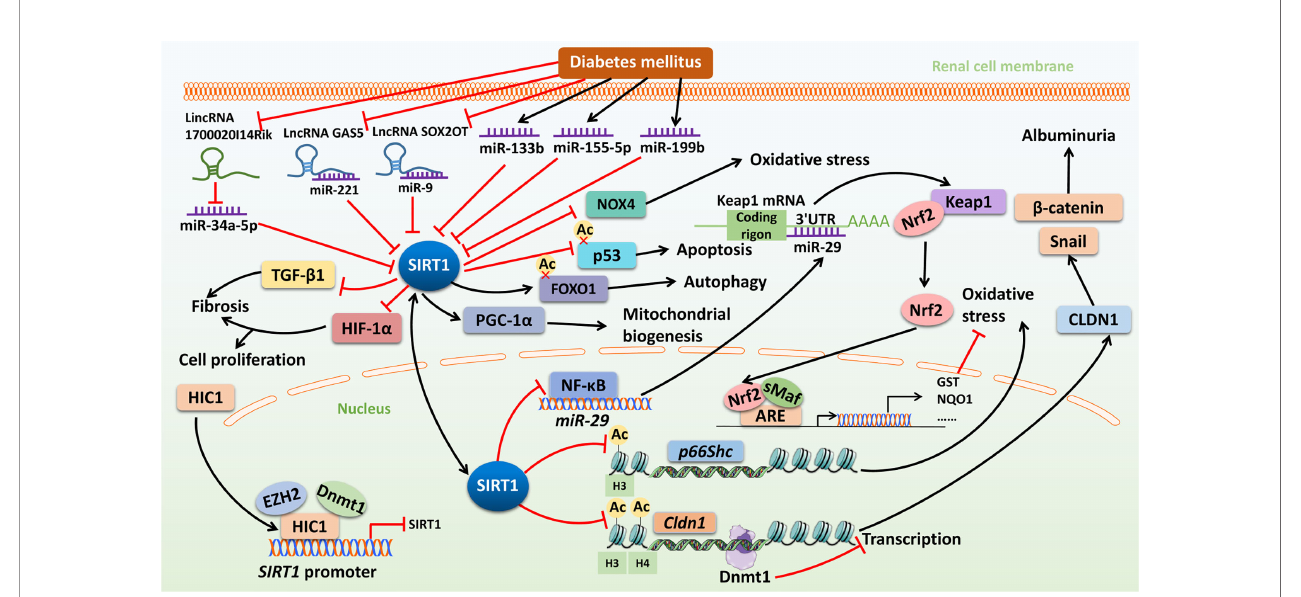
FIGURE 2 | The mechanisms of action and signaling pathways of SIRT1 in diabetic nephropathy. Diabetes mellitus (DM) can inhibit SIRT1 expression by increased expression of miR-34a-5p, miR-221, miR-9, miR-133b, miR-155-5p, and miR-199b. HIC1 can repress SIRT1 transcription in response to HG stimulation via an interaction with EZH2 and Dnmt1. Overexpression of SIRT1 can blunt CLDN1/ b -catenin-Snail-mediated albuminuria in DN via the deacetylation of histones H3 and H4 with subsequent CpG methylation of Cldn1 by recruiting Dnmt1. SIRT1 activation can inhibit p66Shc expression to improve oxidative stress in DN by deacetylation of acetyl-H3. SIRT1 activation can upregulate miR-29 expression by reduction of NF- k B binding to its promotor. Overexpression of miR-29 directly targets Keap1 mRNA to decrease Keap1 expression and subsequently increase Nrf2 expression. Free Nrf2 translocates to the nucleus, where it dimerizes with members of the sMaf family and binds to ARE within regulatory regions of a wide variety of cell defense genes, including GST and NQO1 . LincRNA 1700020I14Rik can interact with miR-34a-5p to inhibit cell proliferation and fi brosis in DN though the SIRT1/HIF-1 a signaling pathway. LncRNA GAS5 and SOX2OT can upregulate SIRT1 expression by sponging miR-221 and miR-9, respectively. SIRT1 can inhibit TGF- b 1-induced renal fi brosis and NOX4-induced oxidative stress, and stimulate PGC-1 a -mediated mitochondrial biogenesis to improve DN. Finally, SIRT1 can deacetylate and activate FOXO1 to upregulate the level of autophagy, and deacetylate and inhibit p53 to inhibit apoptosis, thus improving DN. SIRT1, Sirtuin 1; DM, diabetes mellitus; miR, microRNA; HIC1, hypermethylated in cancer 1; HG, high glucose; EZH2, enhancer of zeste homolog 2; Dnmt1, DNA methyltransferase 1; CLDN1, claudin-1; DN, diabetic nephropathy; NF- k B, nuclear factor kappa B; Keap1, Kelch-like ECH- associated protein 1; Nrf2, nuclear factor erythroid 2-related factor 2; sMaf, small Maf; ARE, antioxidant response element; GST, glutathione S- transferase; NQO1, nicotinamide adenine dinucleotide phosphate (NADPH) quinone dehydrogenase 1; LincRNA, long intergenic non-coding RNA; HIF- 1 a , hypoxia-inducible factor-1 a ; LncRNA GAS5, long non-coding RNA growth arrest special 5; SOX2OT, SOX2-overlapping transcript; TGF- b 1, transforming growth factor-beta 1; NOX4, NADPH oxidase 4; PGC-1 a , peroxisome proliferator-activated receptor gamma coactivator-1 alpha FOXO1, forkhead box O 1; p53, tumor protein